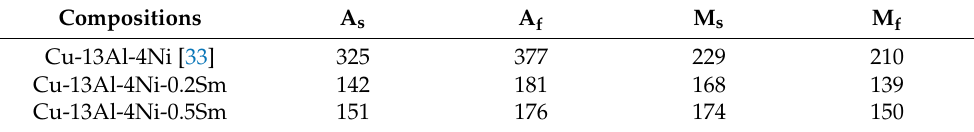
Figure 4. DTA of Cu-13.0Al-4.0Ni- x Sm ( x = 0.2, 0.5) alloys. Table 1. Martensitic transformation temperature (°C) of the Cu-13.0Al-4.0Ni- x Sm ( x = 0.2, 0.5) alloy.